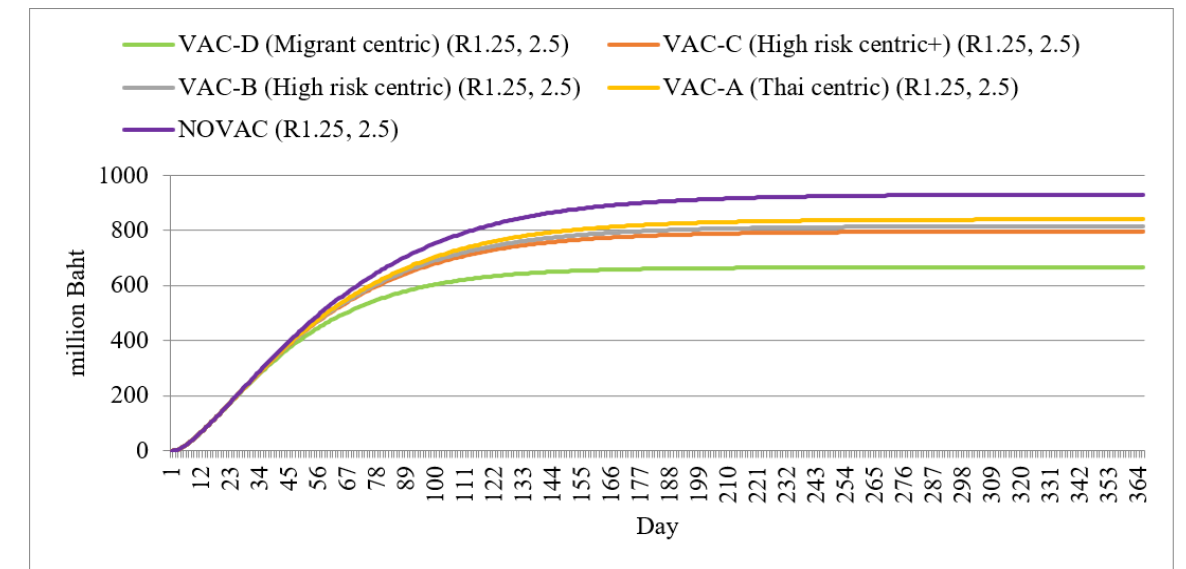
Figure 7. GDP loss by different policy scenarios.